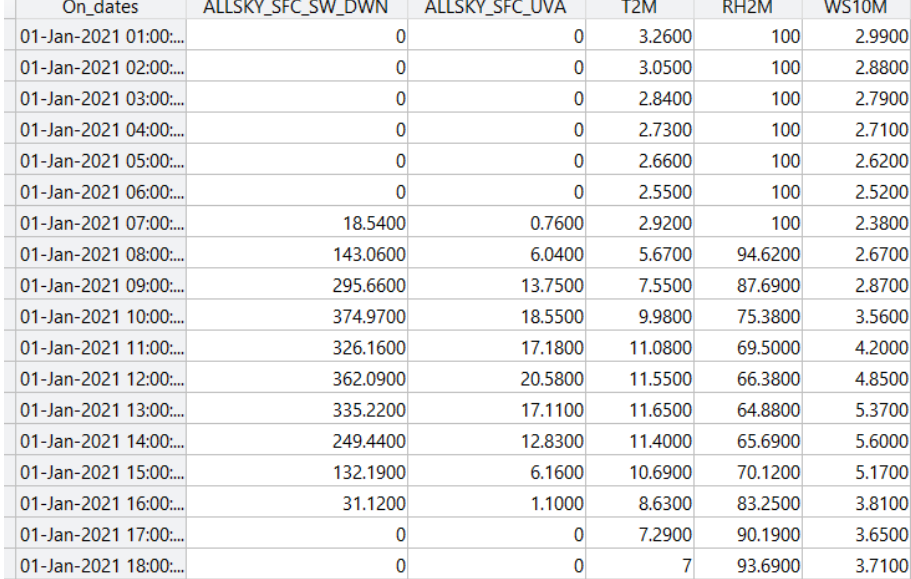
Table 1. Parameter estimates of cumulative effects model along with confidence interval